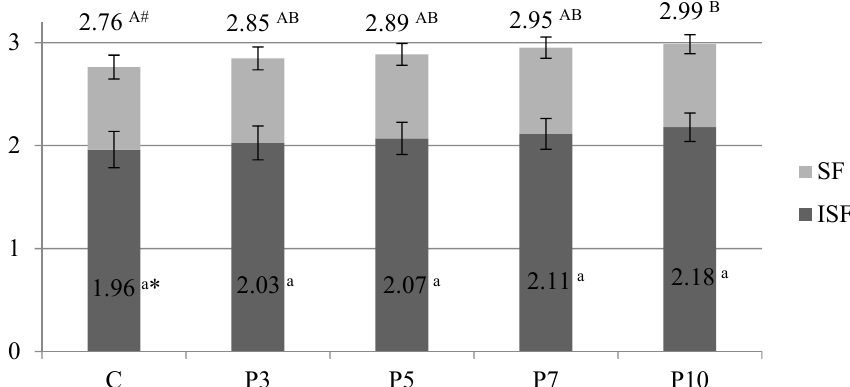
Figure 1. Fiber content in the analyzed pasta samples (g/100 g dry matter). C—control (semolina pasta); P3, P5, P7, P10—pasta samples with 3, 5, 7, 10 percentage replacement of semolina flour with spirulina powder. The bars show the total fiber content divided into a dark grey part (insoluble fiber content, ISF) and a light grey part (soluble fiber content, SF). Bars represent means ± standard deviation, ( n = 3, for each pasta variant). * The values refer to the ISF content, marked with the same lowercase letter (a) are not significantly different ( p < 0.05). # The values refer to the total fiber content, marked with different capital letters (A, B) are significantly different ( p < 0.05).